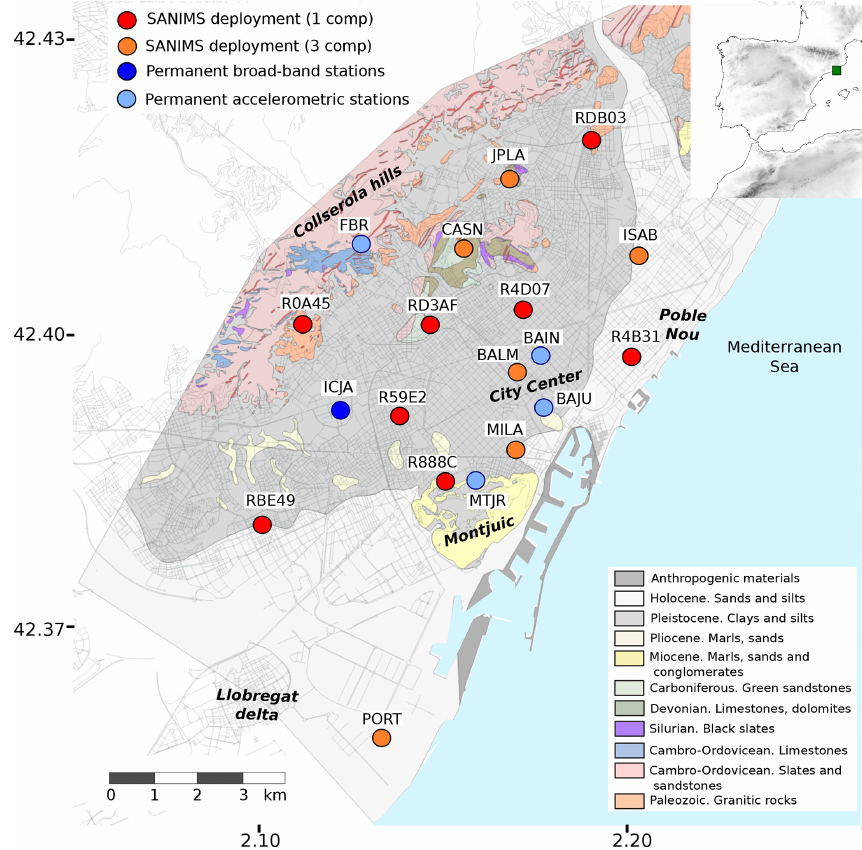
Figure 1. Location plan of the available seismic stations on the geotechnical map of Barcelona. The color code for the different types of instruments used is shown at the top-left corner. Road map from © OpenStreetMap contributors 2020, distributed under a Creative Commons BY-SA